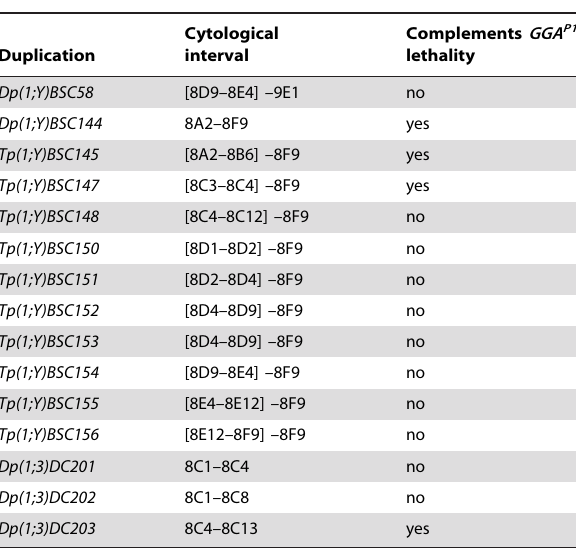
Table 1 Complementation mapping of lethal mutation associated with GGA P1